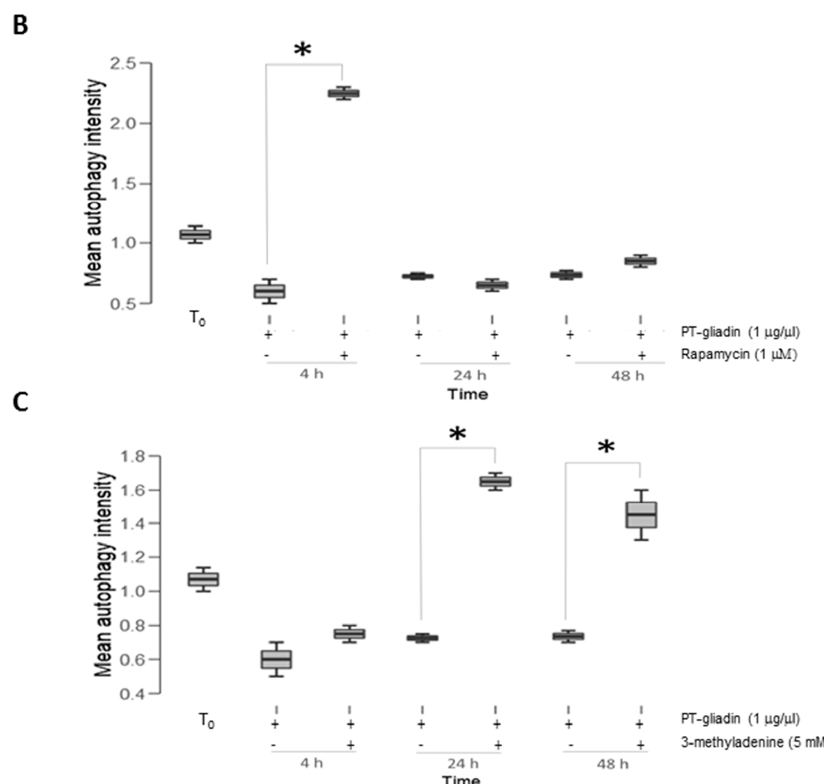
Figure 10. LC3-II expression following modulation of autophagy in Caco-2 cells incubated with PT-gliadin. LC3-II expression in Caco-2 cells treated with PT-gliadin (1 µg/µL), after starvation ( A ), rapamycyn (5 µM) ( B ) or 3-methyladenine (5 mM) ( C ) administration, during different time intervals (hours). Asterisks indicate statistical significance p < 0.05, Anova One-way, as compared to untreated NT samples at T 0 .